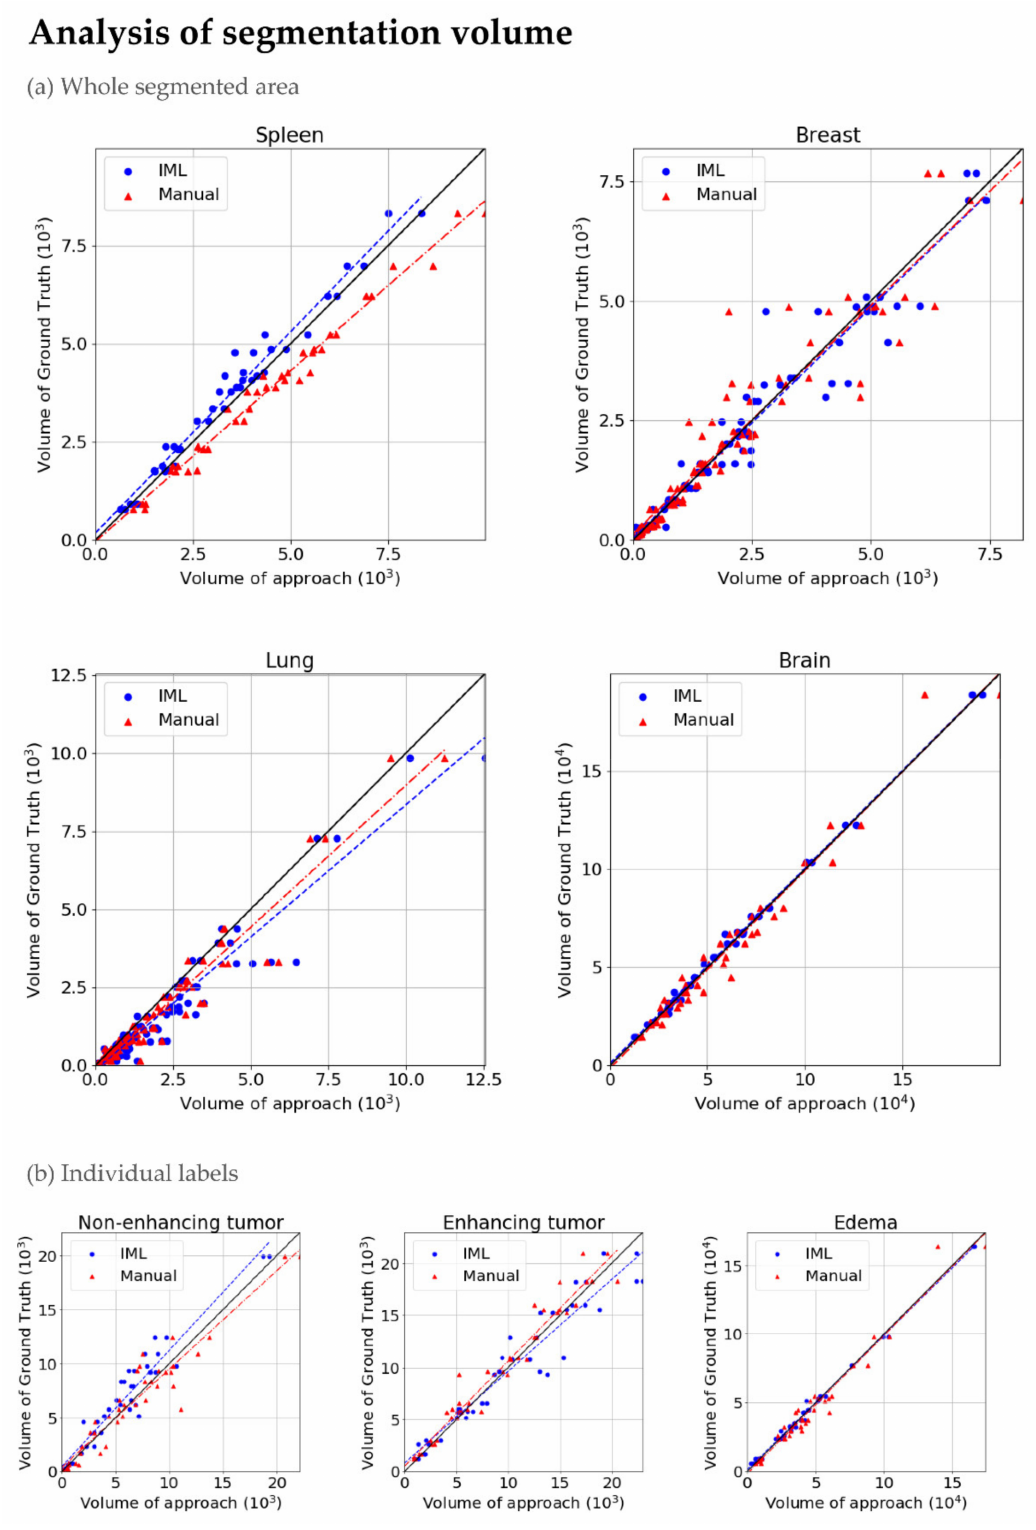
Figure 5. Scatterplots in which blue points are the pairs of volume of Interactive ML (IML) method and volume of ground truth and red are the pairs of manual segmentation volume and ground truth. The black line represents the ground truth’s volume. The plots belong to ( a ) Different cohorts where all individual labels, representing different areas of the structure, are counted as one; ( b ) The sub-regions of